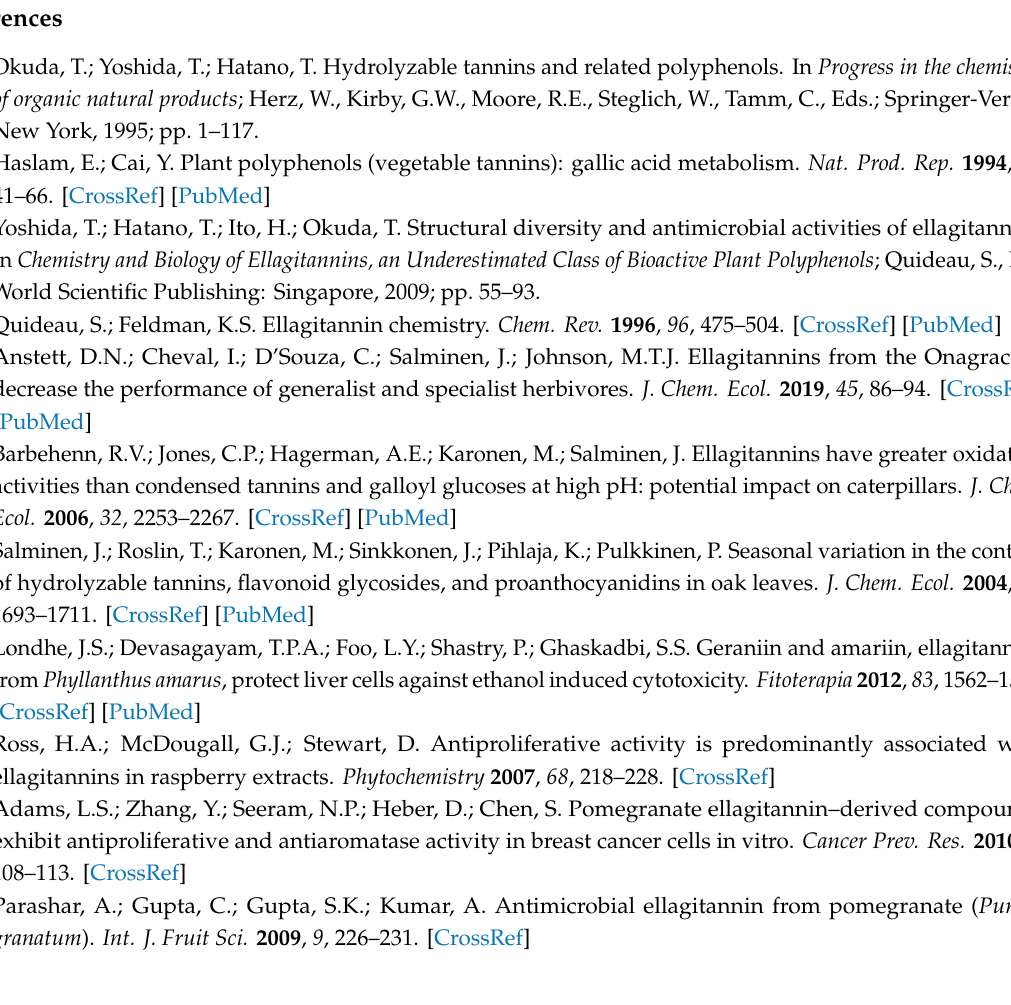
( 1 ) in pH 6 citrate-phosphate bu ff er, Figure S4. HPLC profiles of isoamariin ( 3 ) in pH 6 citrate-phosphate bu ff er, Figure S5. Structures of minor products produced by degradation of 1 , Figure S6. HMBC correlations and ECD spectra of 1- O -galloyl-3,6-( S )-HHDP- β - d -glucose. Figure S7. HPLC profile (A) and UV spectrum (B) of oligomeric polyphenol fraction obtained from 2 , Figure S8. 13 C NMR spectrum of oligomeric polyphenol fraction measured in acetone- d 6 . Figure S9. HPLC profiles of acid hydrolysis of 2 , 1- O -galloyl-2,4-( R )-DHHDP- β - d -glucopyranose, and 1- O -galloyl-3,6-( R )-HHDP- β - d -glucopyranose. Figures S10–S31, 1D, 2D NMR spectra of compounds 1 , 1a , 3 , 3a , and 9 , and computational